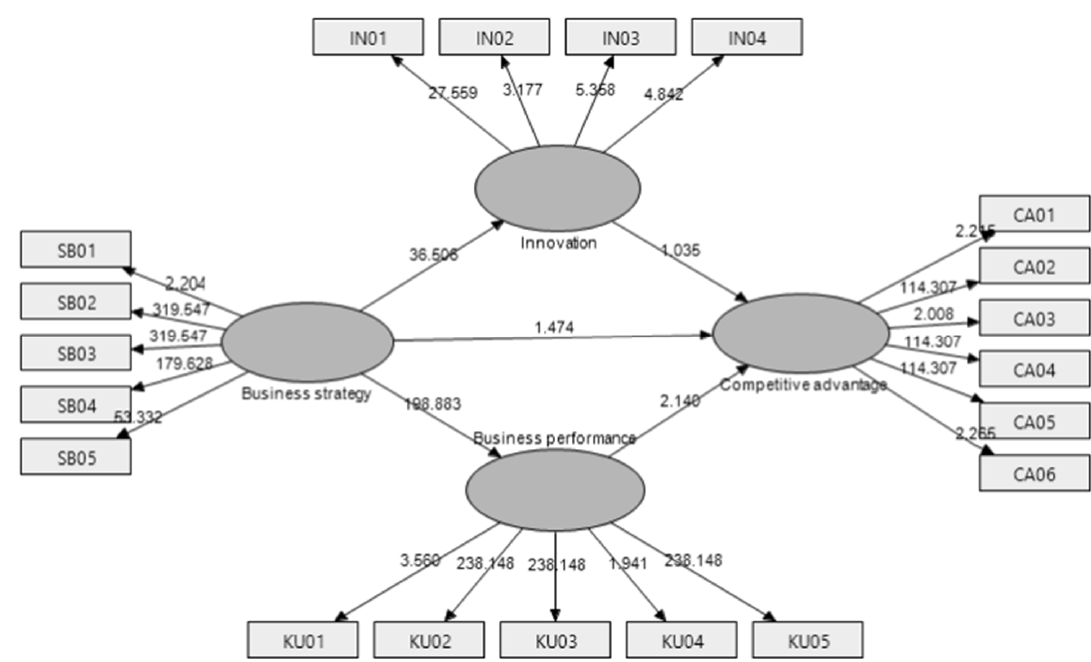
Figure 4. Hypothesis test results.